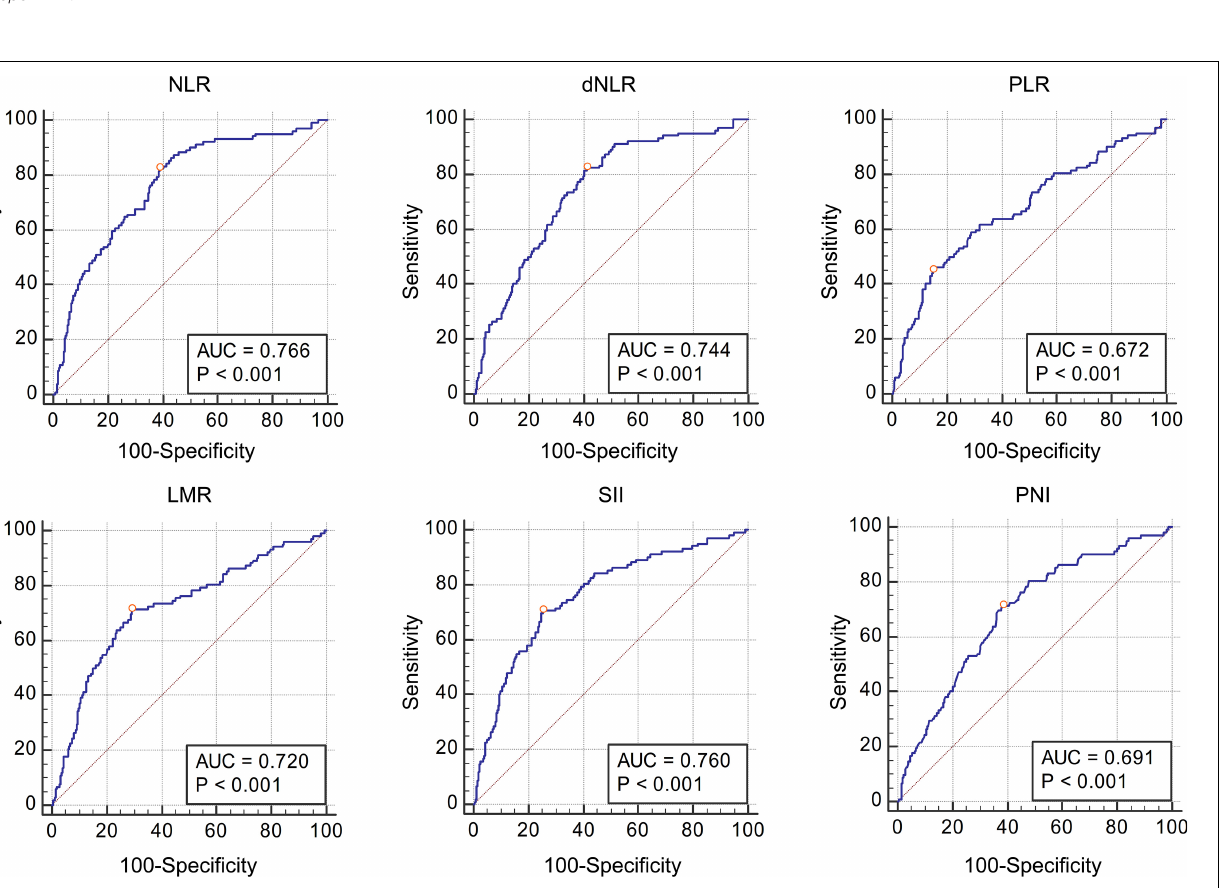
FIGURE 2 | The Receiver Operating Characteristic curves and Area Under Curve of NLR, dNLR, PLR, LMR, SII, and PNI for muscle invasion. All these inflammatory factors had predictive value for pathological grade ( P < 0.001, P < 0.001, P < 0.001, P < 0.001, P < 0.001, and P < 0.001 respectively), and the optimal cut-off values were 6.85, 4.23, 248.86, 2.01, 1723.14, and 50.90,